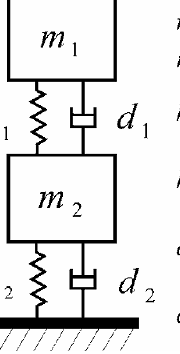
Fig. 4. Two degree-of-freedom system for numerical investigations.